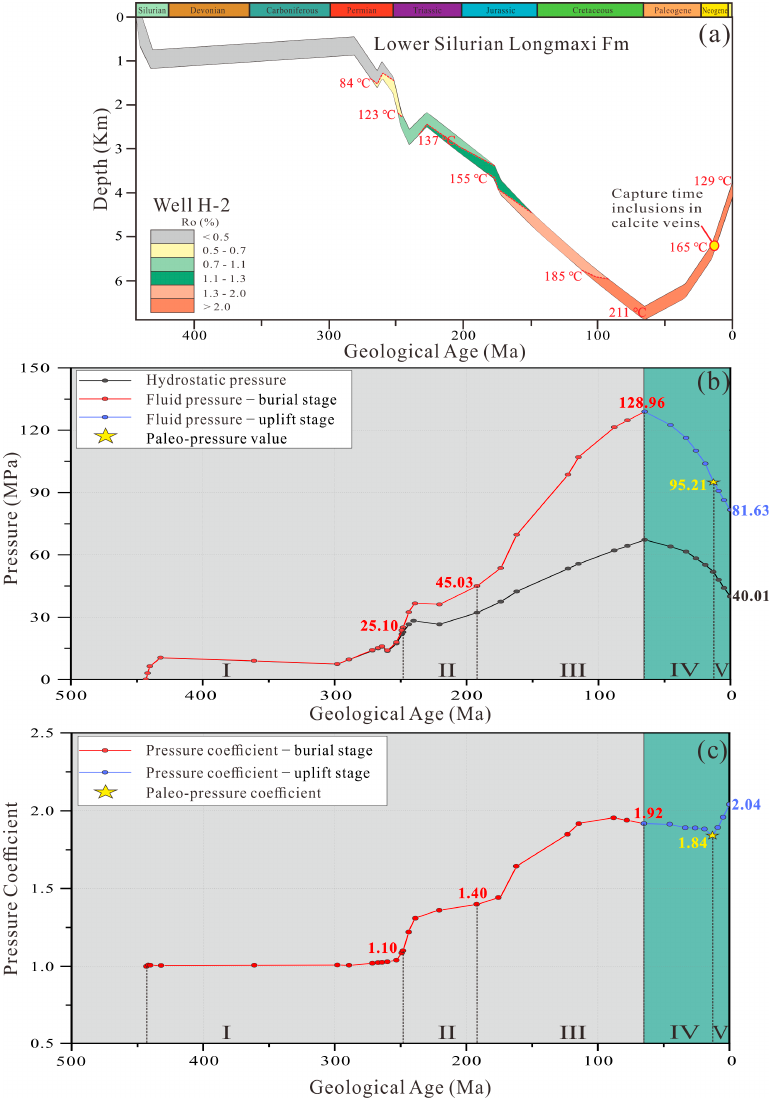
Figure 13. Overpressure evolution of deep Longmaxi Fm shale reservoir in the Southern Sichuan Basin. ( a ) Burial, thermal, and maturity histories of the Mbr 1 1 of Longmaxi Fm shales, presenting the formation temperature corresponding to different mature stages and the trapping temperature obtained by inclusion analysis (165 °C); ( b ) evolution of hydrostatic pressure and fluid pressure of shale reservoir, illustrating fluid pressure increases to 128.96MPa during the long-term subsidence stage owing to hydrocarbon generation expansion and decreases to 81.63MPa at the late strong uplift stage because of temperature reduction and gas escape.; ( c ) evolution of pressure coefficient of shale reservoir, showing an apparent five stages from 445 Ma to present.